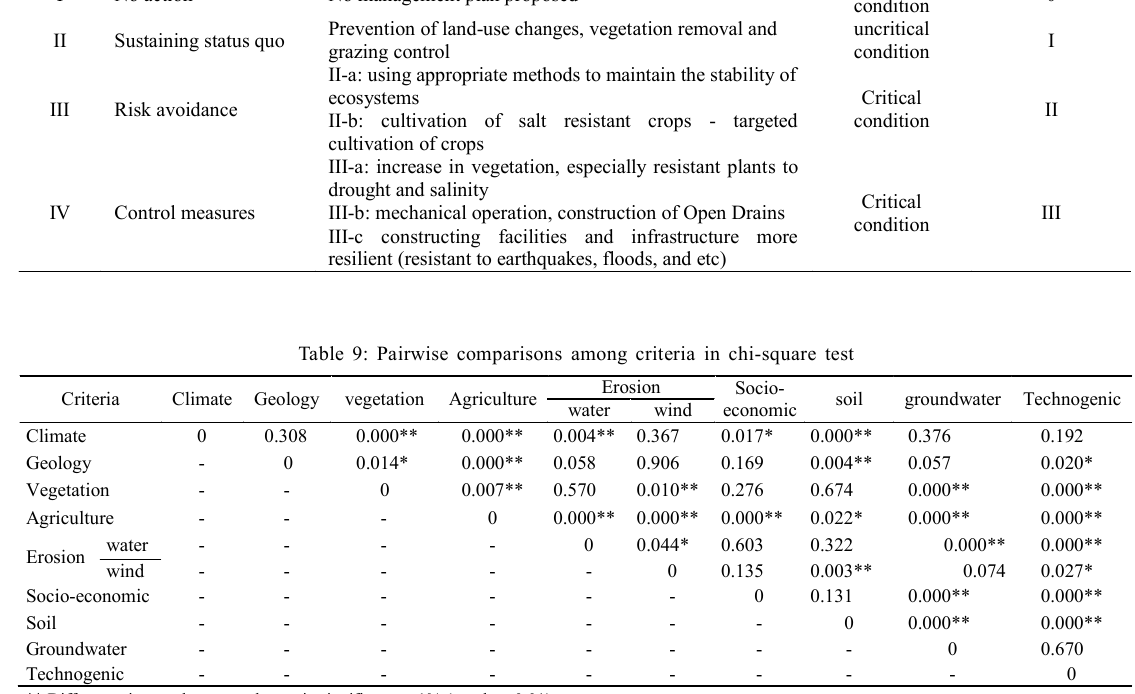
Table 11 states that the weighted average values of the criteria and desertification classes. Fig. 3 shows a map of desertification hazard in the study area.